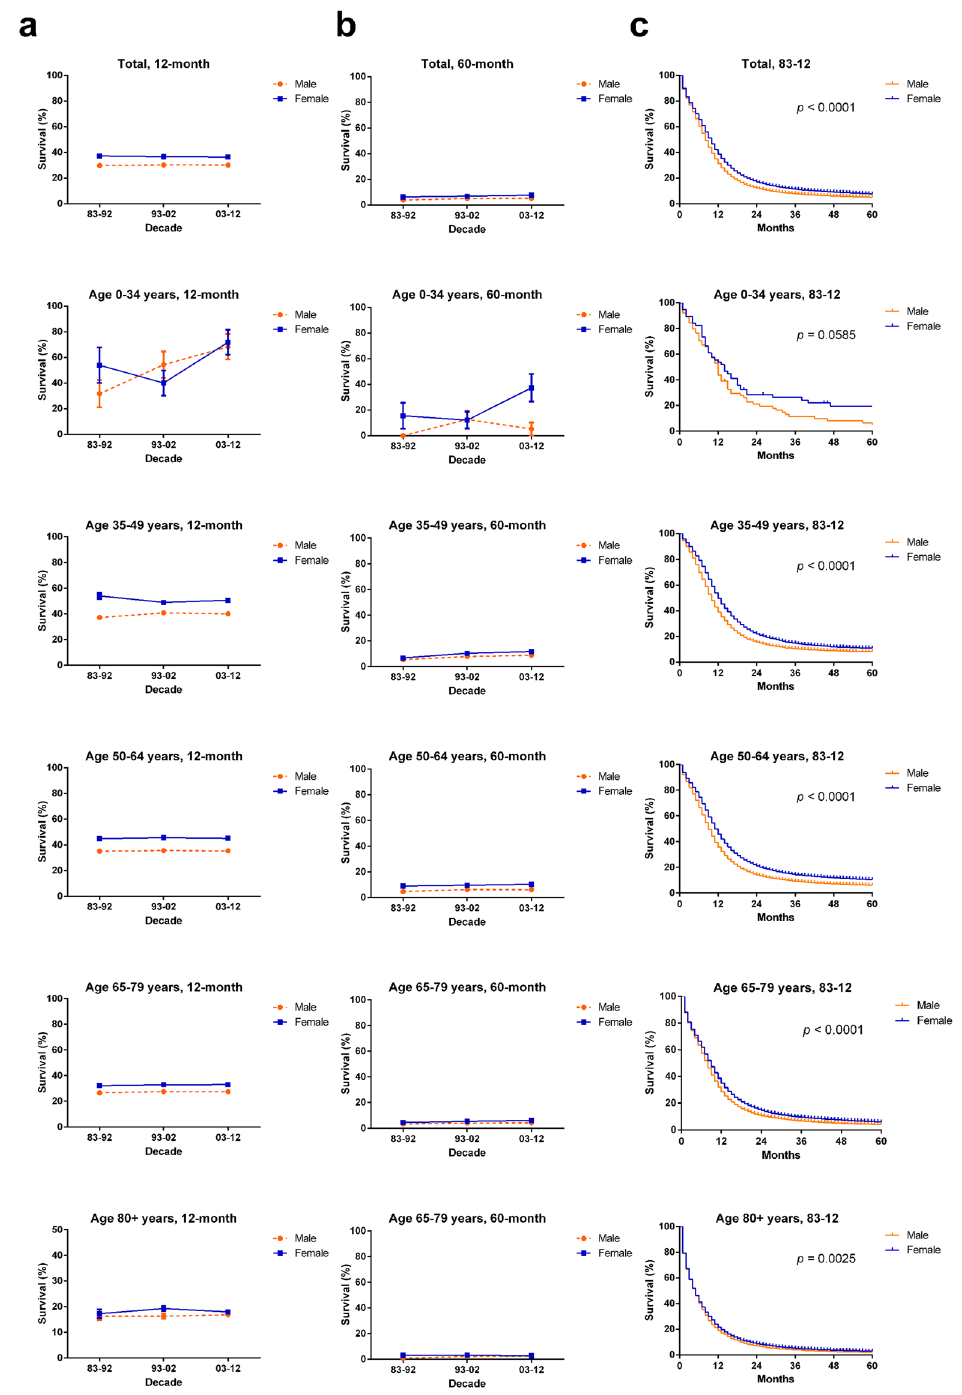
Figure 3. 12-month ( a ), 60-month ( b ) relative survival rates and Kaplan-Meier survival analyses from 1983 to 2012 ( c ) for patients with SCLC at 18 SEER sites according to sex by age group (total and ages 0–34, 35–49, 50–64, 65–79, and 80 +